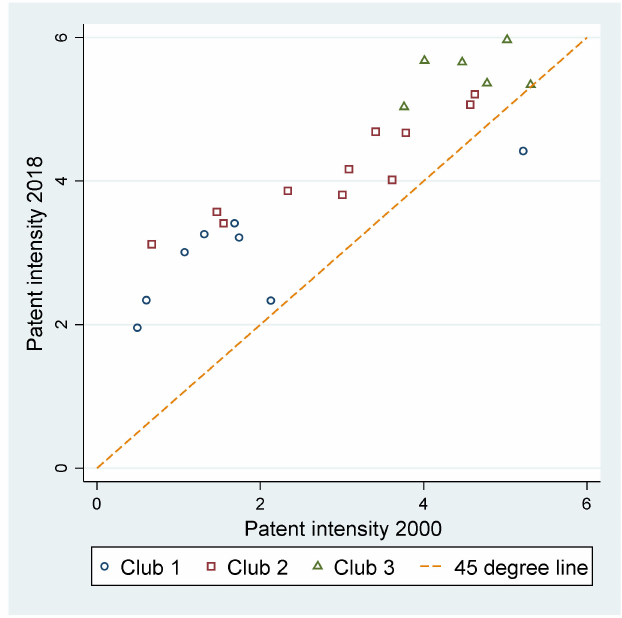
Figure 2. Shifts in energy patent intensity in